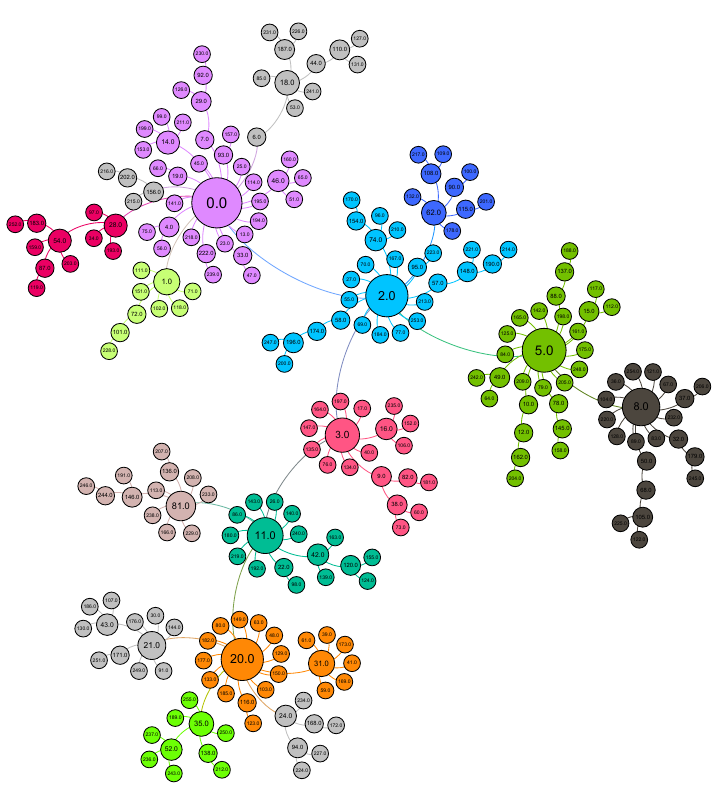
Figure 2. Synthetic network consisting of 256 users generated using the Barabasi Albert Model.